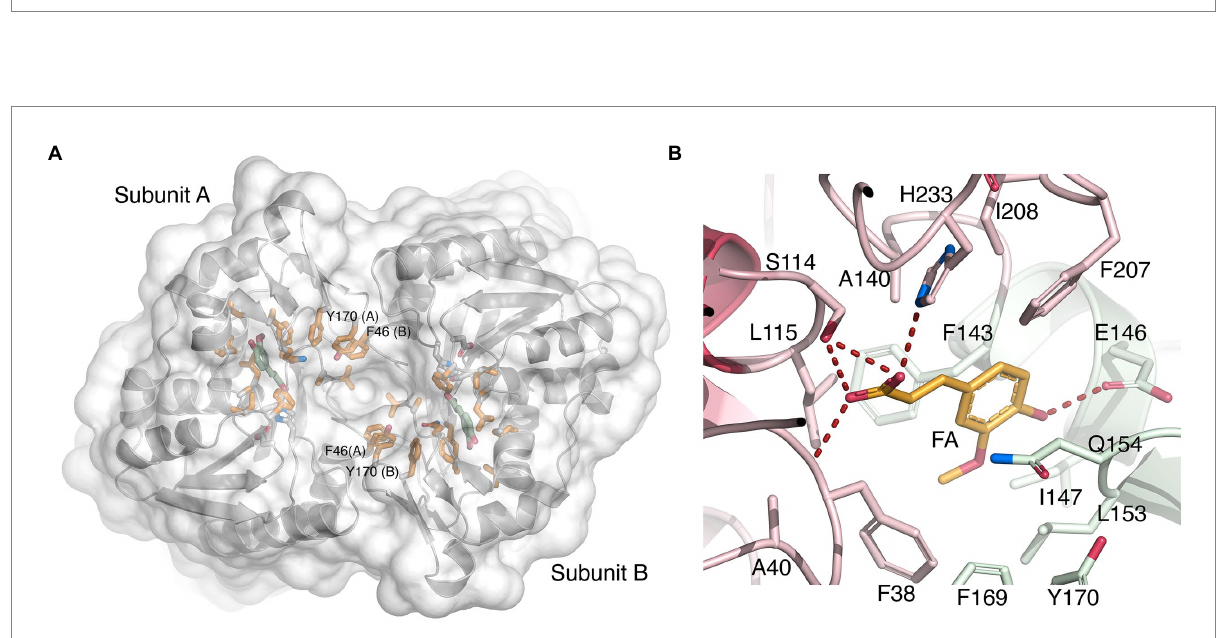
FIGURE 5 Dimer structure and surface electrostatics. Top row: ribbon drawings with an overlaid semitransparent gray molecular surface showing the Lb FAE homodimer in three orientations (A) side view, (B) bottom view, and (C) top view. The α / β domain is colored red, and the lid domain is green. Ferulic acid is shown in orange. Bottom row: electrostatic potential surfaces calculated at pH 6.5 and colored in the range − 5.0 to 5.0 kT/e. The entrance to the active site is located at the bottom of the dimer, which is emphasized in orientation B.